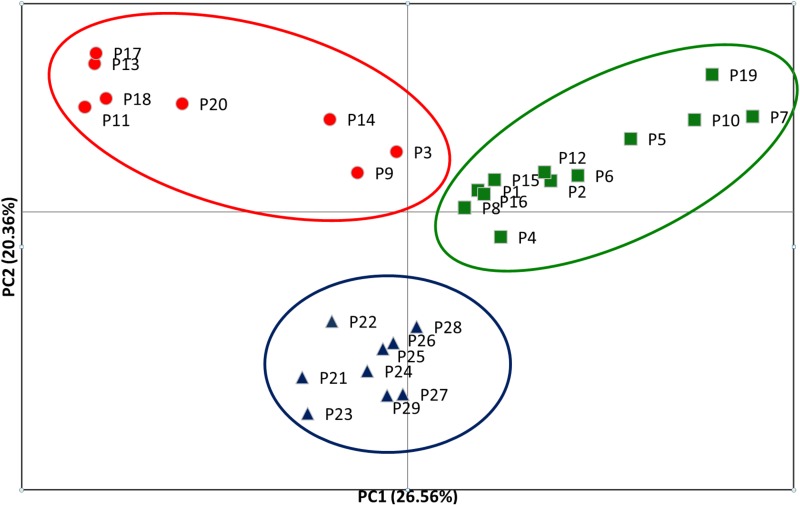
Principal coordinate analysis (PCoA) based on Fst genetic distances for 29 studied populations of Pulsatilla patens s.s.Encircled populations correspond to the three clusters identified by the STRUCTURE analysis. The symbols denote three genetic clusters.